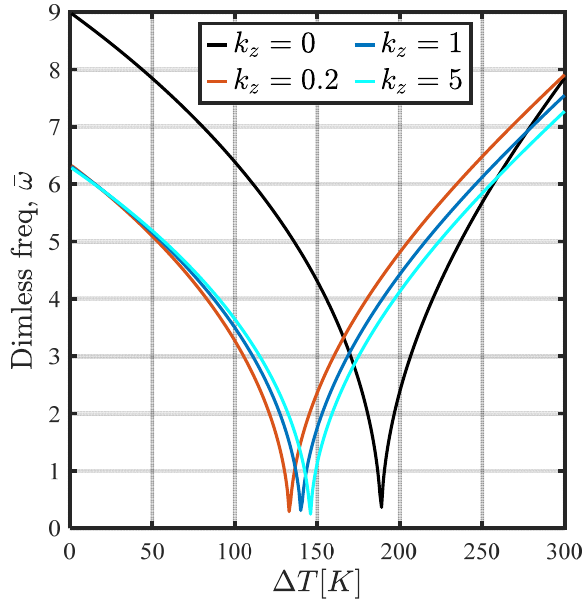
Figure 4. Influence of the transverse gradient index on the dimensionless fundamental frequency at different temperature differences ∆ T under LTR and based on classical analysis ( l = 0, k x = 0.2 )